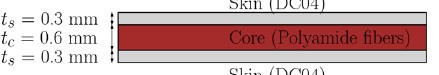
Fig. 4 The skins of the Hybrix™ are based on 0.3 mm thick carbon steel (DC04), enclosing the 0.6 mm core, based on polyamide fibers